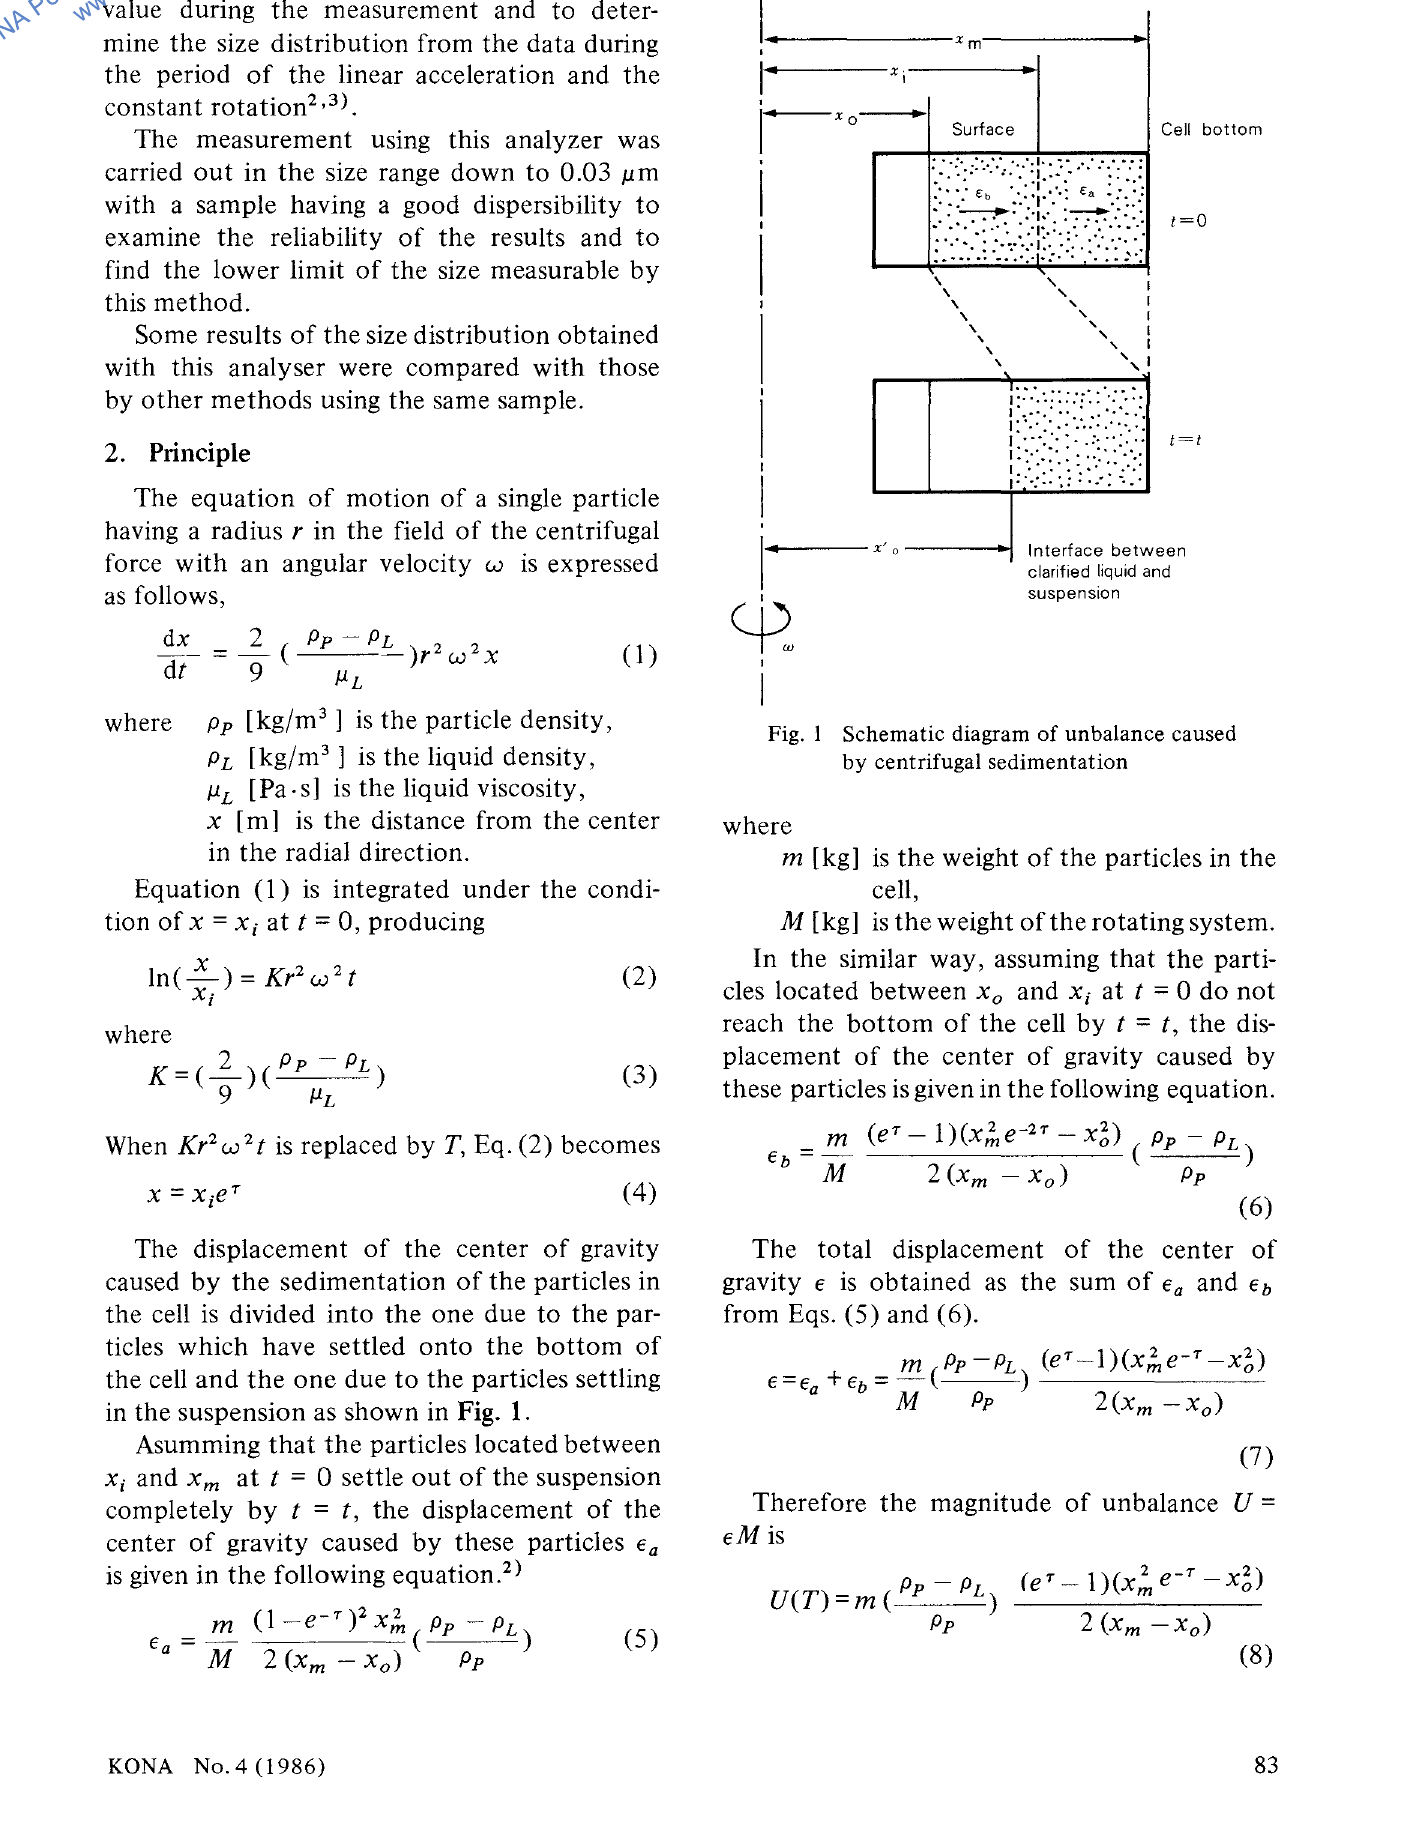
Fig. 1 Schematic diagram of unbalance